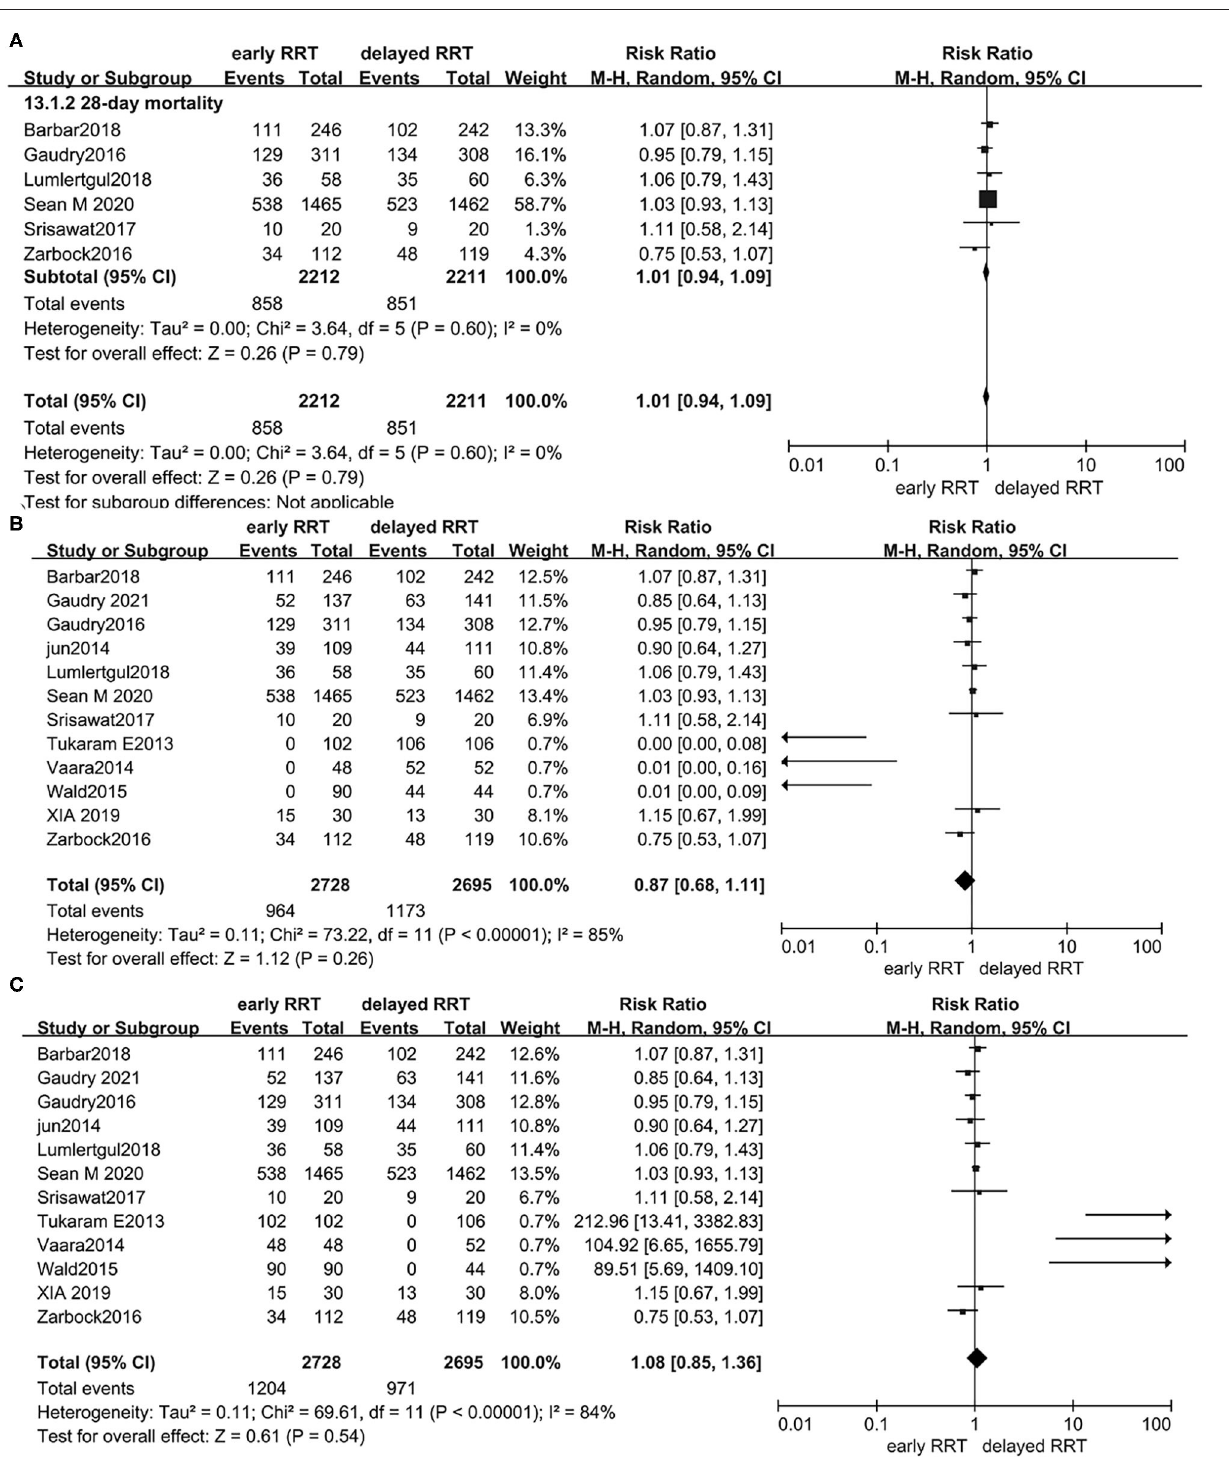
FIGURE 5 | Forest plot for all-cause mortality at day 28 of sensitivity analysis by removing individual trials at a time with non-low bias in each domain (A) ; best-worst-case scenario random-effects meta-analysis for the rate of all-cause mortality at day 28 (B) ; and worst-best-case scenario random-effects meta-analysis for the rate of all-cause mortality at day 28 (C)